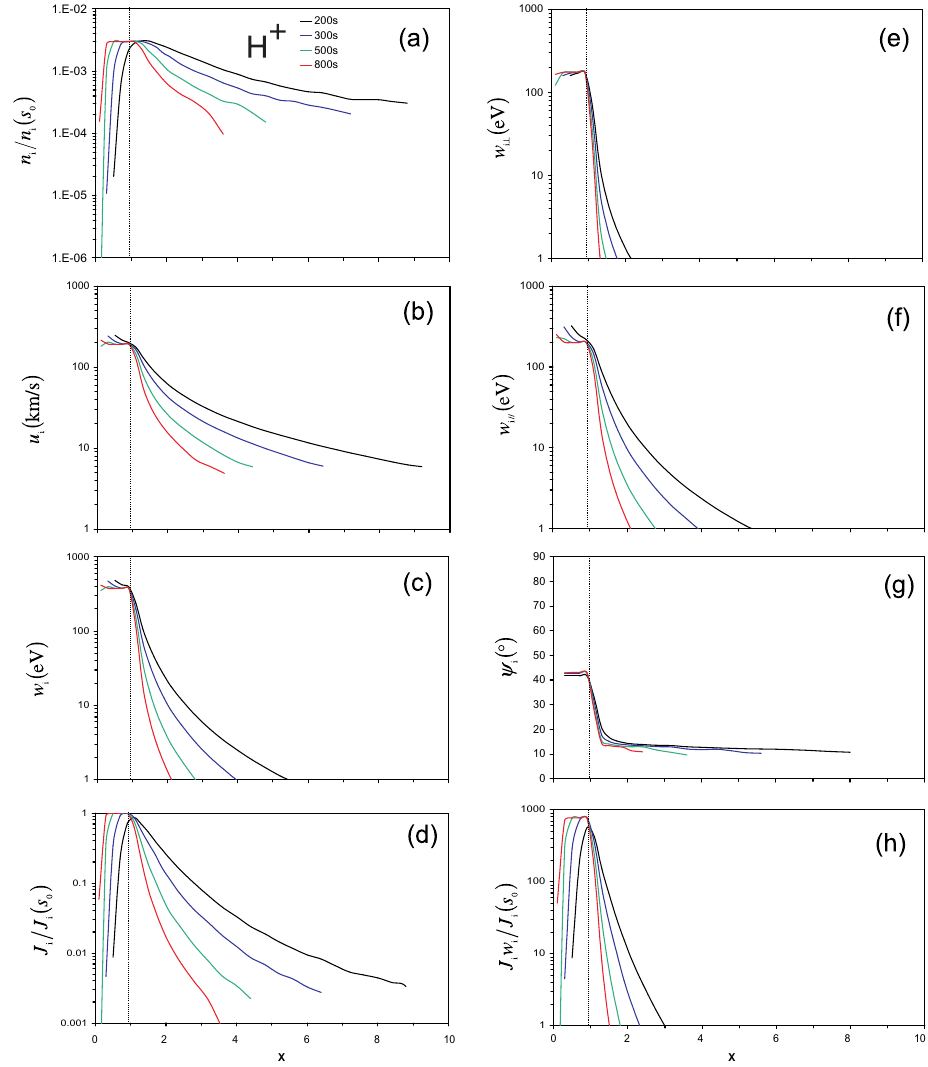
Fig. 10. Evolution of H + moments versus X at an altitude of 2 R E . The format is the same as in Fig. 8.